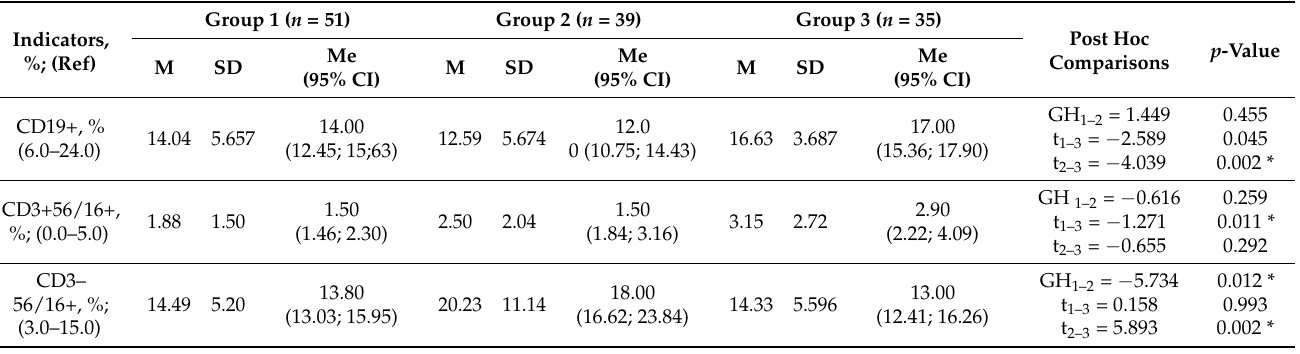
Table 2. Comparative analysis of indicators of B- and NK cells of workers of three groups in chrysotile asbestos production.